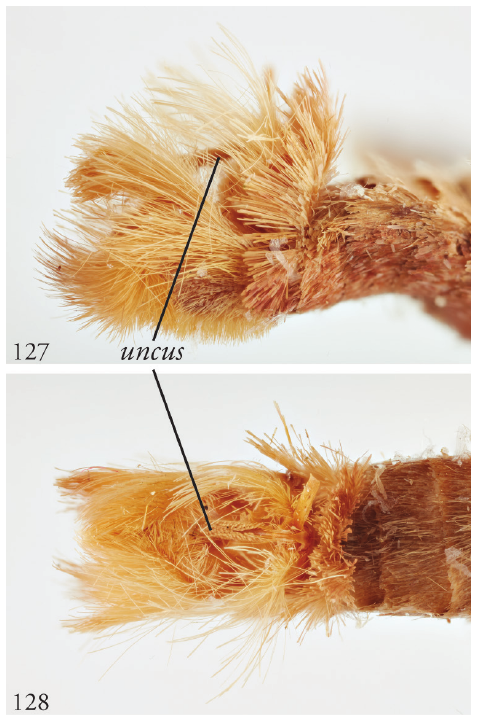
Figures 127–128. Leucosigma viridipicta Holotype terminalia in situ , indicating clustered setae on the uncus. 127 Lateral 128 Dorsal.